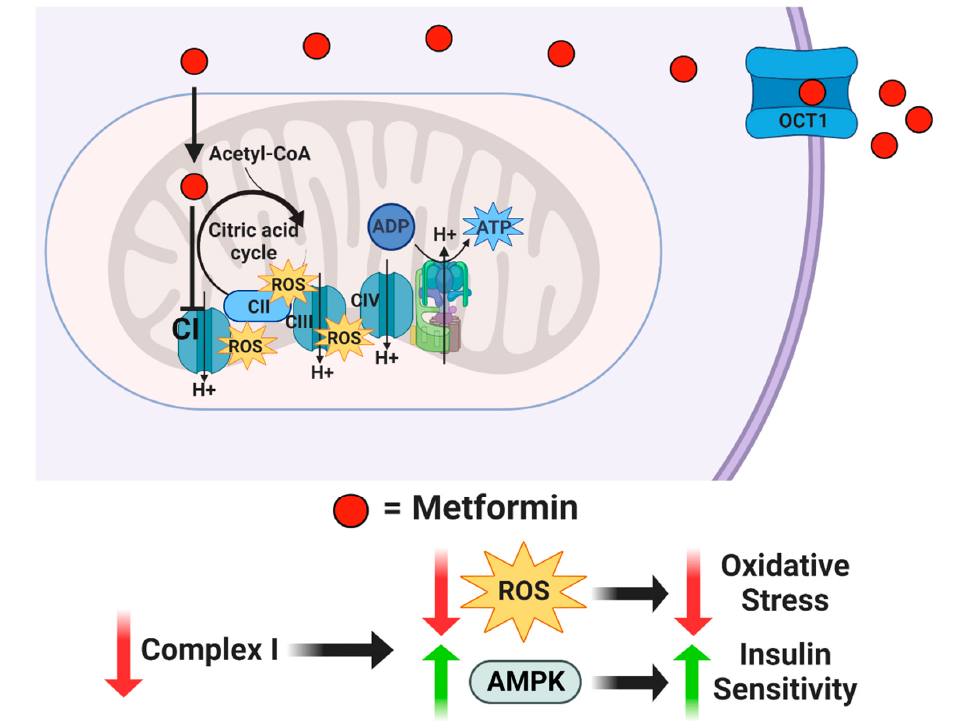
Figure 1. Proposed mechanism of action for metformin. Metformin enters the cell through organic cation transporter 1 (OCT1) and is transferred into the mitochondria by its positive net charge. Once inside the mitochondrial matrix, metformin inhibits Complex I, which reduces reactive oxygen species while increasing AMPK.